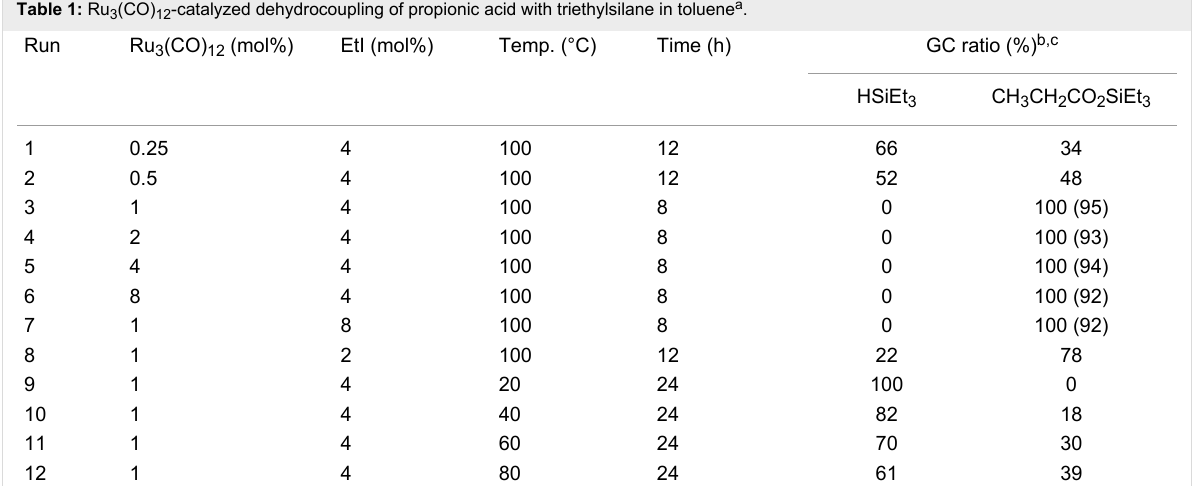
Table 1: Ru 3 (CO) 12 -catalyzed dehydrocoupling of propionic acid with triethylsilane in toluene a .